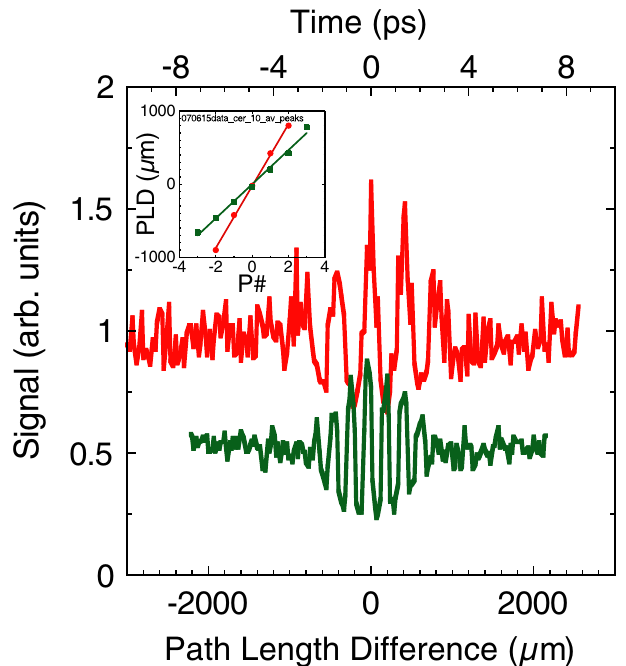
FIG. 11. (Color) Normalized CTR interferometer traces ob- tained with two different incoming energy spectra: (cid:1) E=E 0 ¼ 1 : 5% (red line, shifted up by 0.5 a.u. after normalization) and 3.4% (green line) and with different energy slit widths leading to three and four bunches, respectively. The dependency of (cid:1) z on the incoming energy spread is clearly visible from the two traces. The distance between the peaks is determined from a linear fit of the measured path length difference (abbreviated PLD) versus peak number (abbreviated P # ) shown in the inset. The slope of the curves is therefore the distance between the